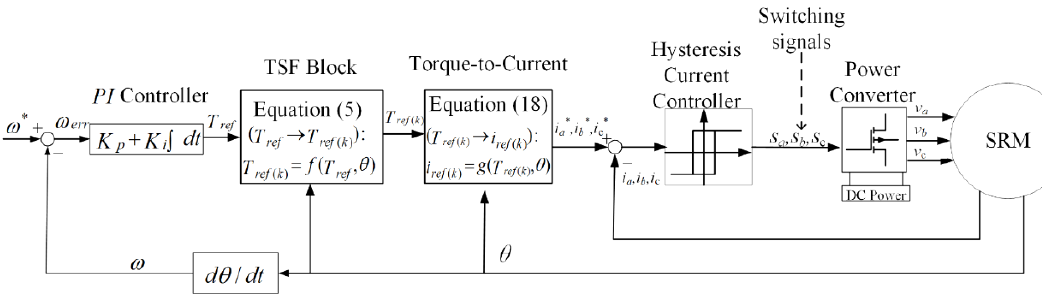
Figure 10. Block diagram of the torque control using the TSF method.